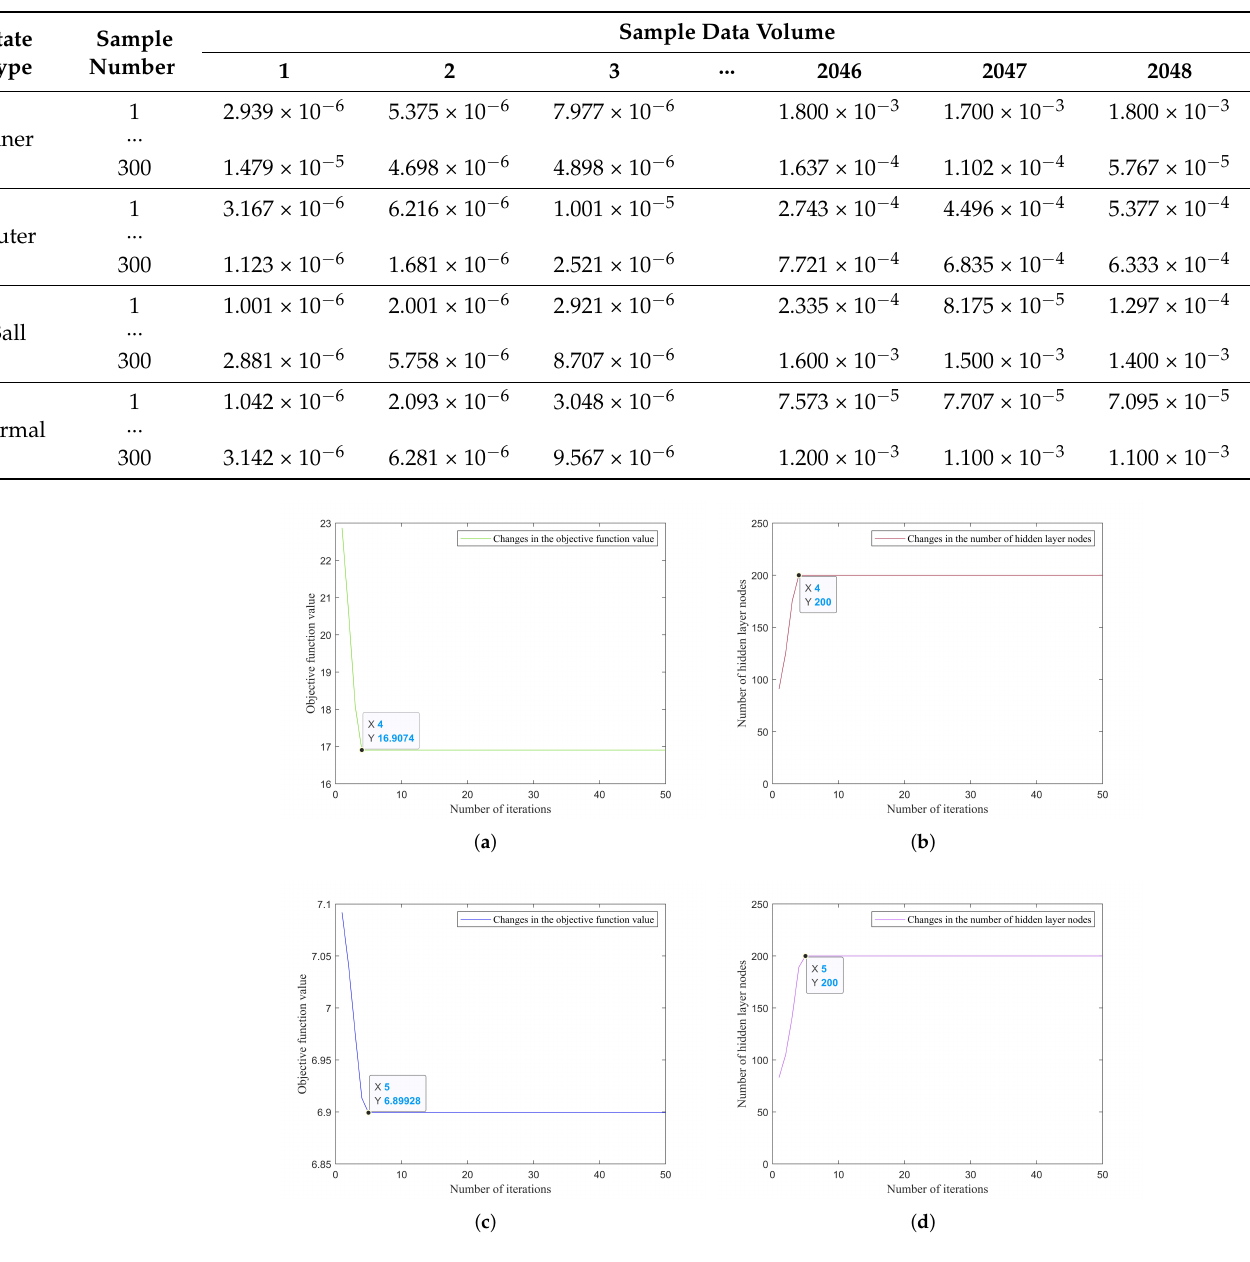
Figure 14. IPSO calculates the number of nodes in each hidden layer of DBN. ( a ) Change curve of the first layer’s objective function value; ( b ) Change curve of the node number in the first layer; ( c ) Change curve of the second layer’s objective function value; ( d ) Change curve of the node number in the second